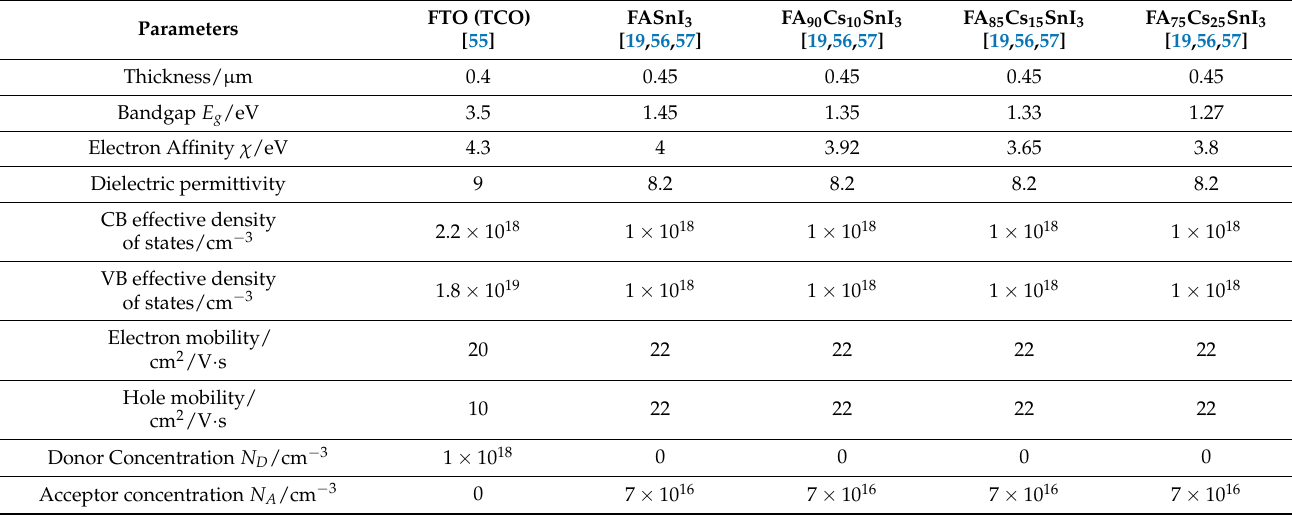
Figure 2. Band alignment between FA 1−x Cs x SnI 3 perovskites and ( a ) ZnOS ETL, ( b ) and TiO 2 ETL. The electrical and optical parameters implemented in the simulation, extracted from both experimental and theoretical works [55 – 64], are grouped in Tables 1 – 3. Conduction band minima and band gap for pure FASnI 3 and the FA 1−x Cs x SnI 3 perovskites were extracted from the experimental studies performed by M. D. McGehee et al. [19]. Different values, such as defect density, thickness, shallow acceptor, electron and hole mobility of the absorber layer and the interface defect between the perovskite from one side and the HTL/ETL from the other side of the absorber layer, were varied to obtain an optimized result and to study their impacts on device performance. Due to their correspondingly high PCEs , the thickness chosen for FTO, ETL, and Cu 2 O were, respectively ,0.40 μm , 0.05 μm , and 0.35 μm (Tables 1 and 2).